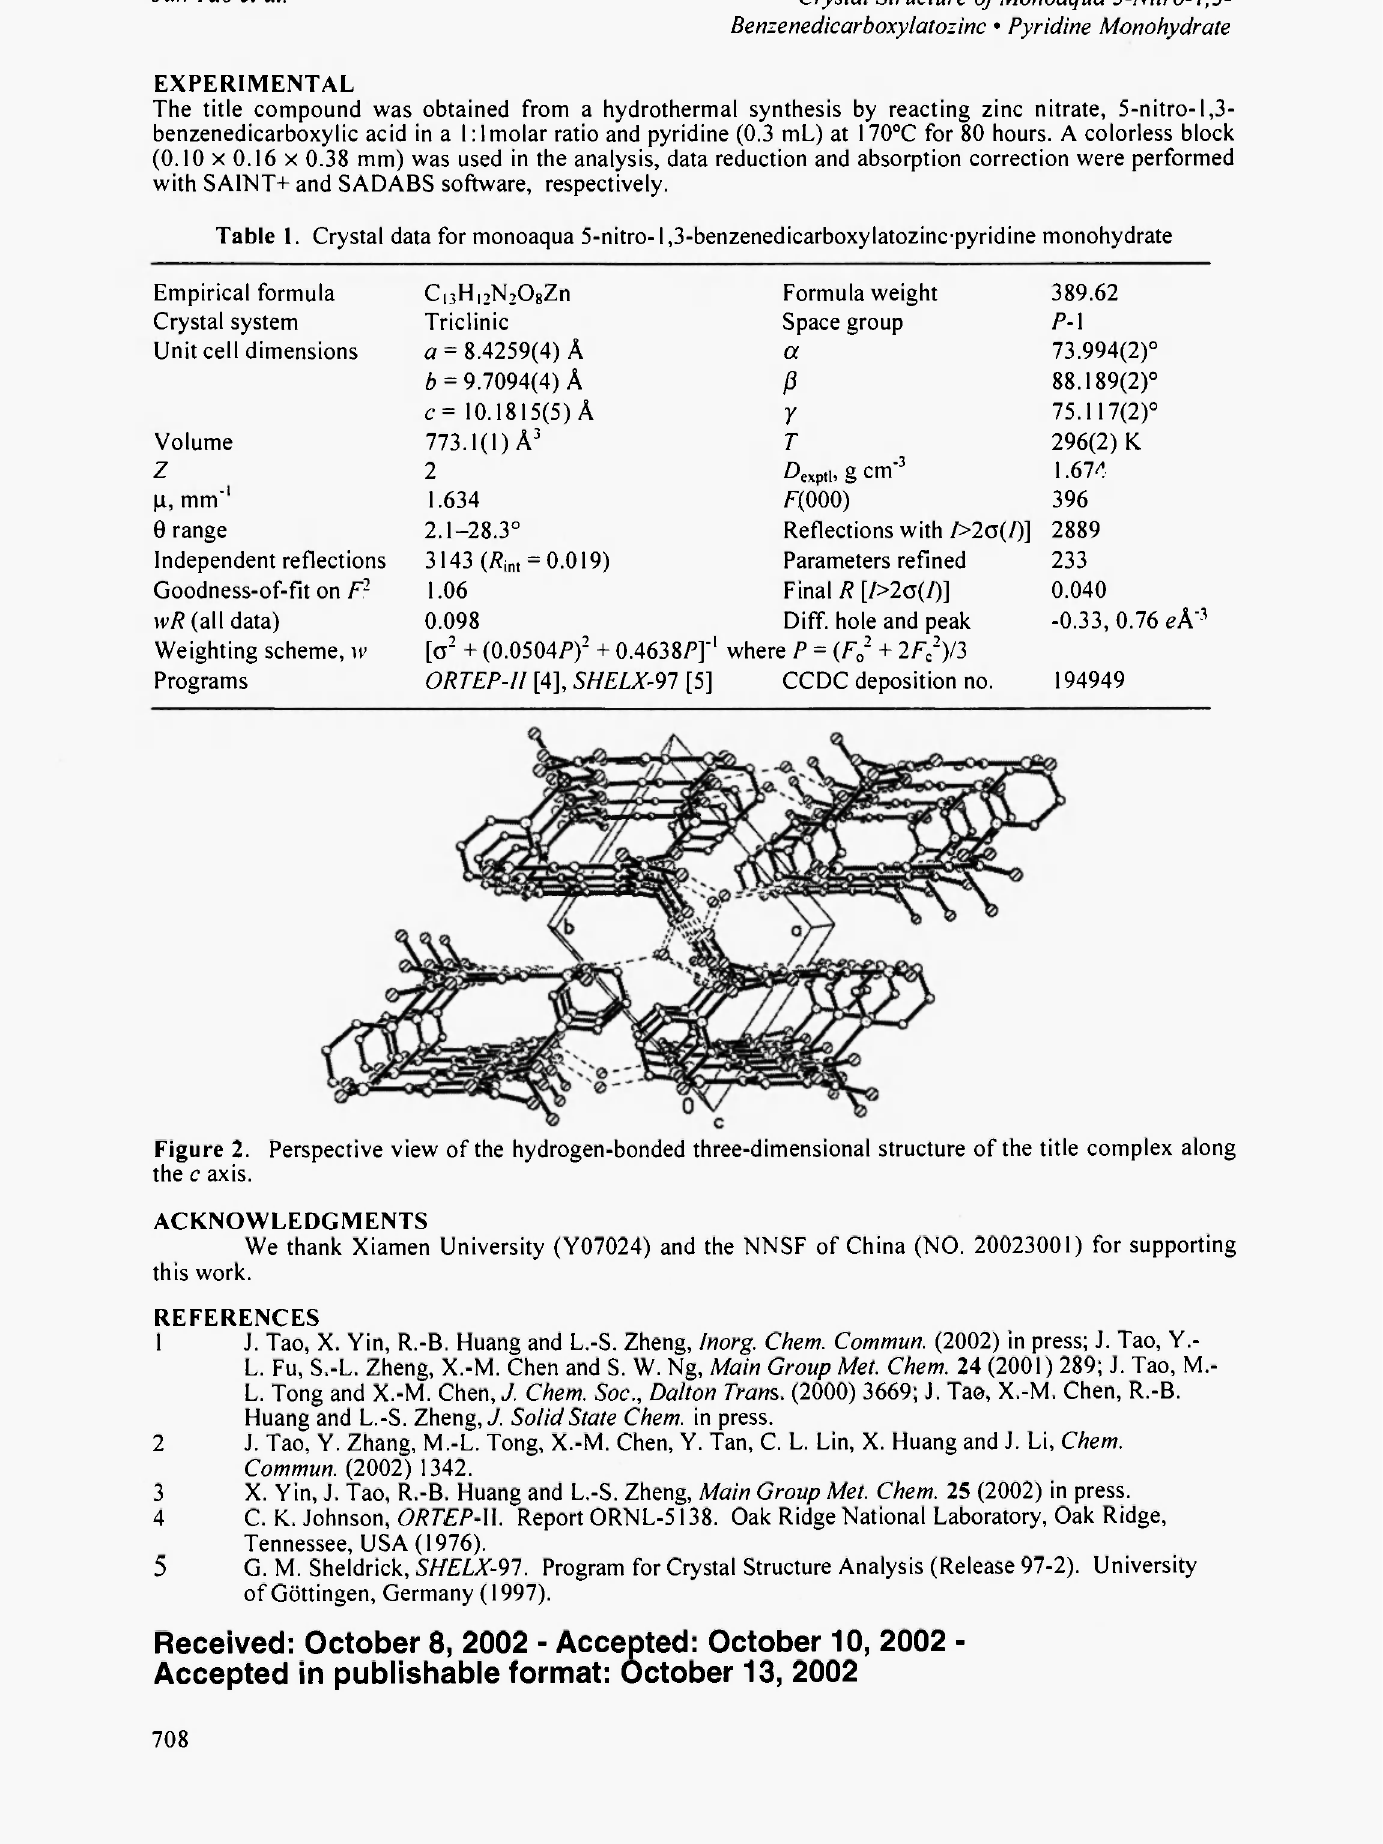
Table 1. Crystal data for monoaqua 5-nitro -l ,3-benzenedicarboxylatozinc-pyridine monohydrate